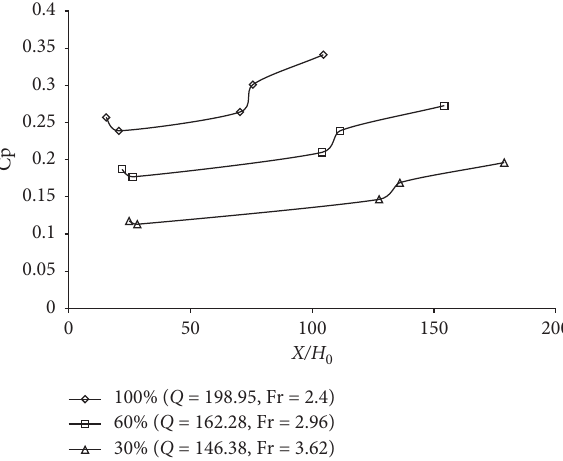
Figure 18: Piezometric pressure head distribution of triple waves for the performance of four middle gates’